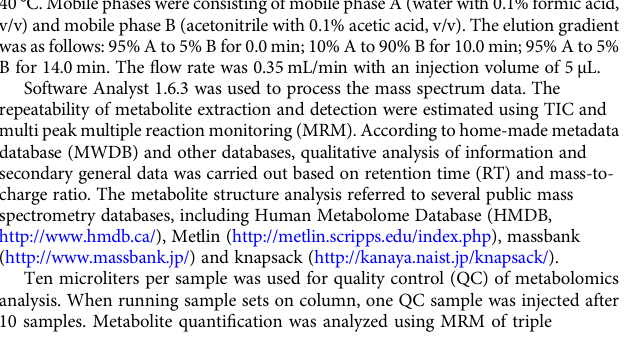
Fig. 8 Schematic representation of signaling pathways regulated by Probio-M9 feeding in C. elegans . Live Probio-M9 feeding increases the lifespan of worms via the Insulin/IGF-1 signaling (DAF-2/SKN-1) and p38 MAPK signaling (NSY-1 – SEK-1 – PMK-1) pathways. It also triggers mitochondrial unfolded protein response (UPR mt ) to maintain mitochondrial homeostasis. Therefore, Probio-M9 feeding extends the lifespan of C. elegans by improving the stress resistance, activating defensive system, and enhancing UPR mt